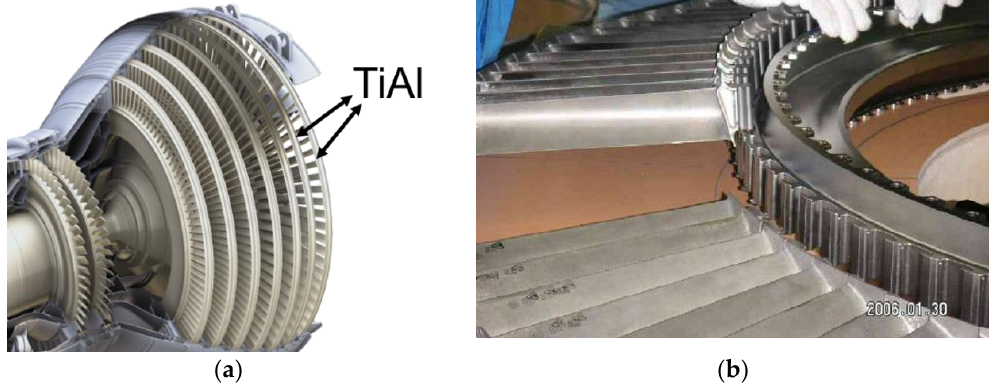
Figure 13. ( a ) The LPT rotor of the GEnx engine which uses 2 stages of Gamma alloy air foils and ( b ) a close up of the disk.